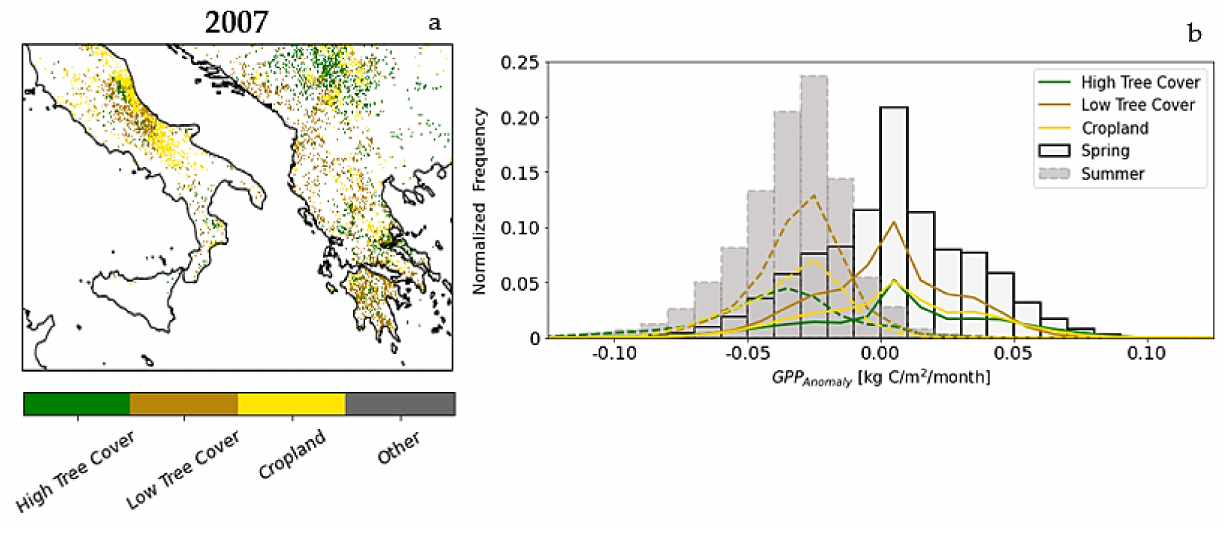
Figure 6. As in Figure 5, but over EM for 2007.